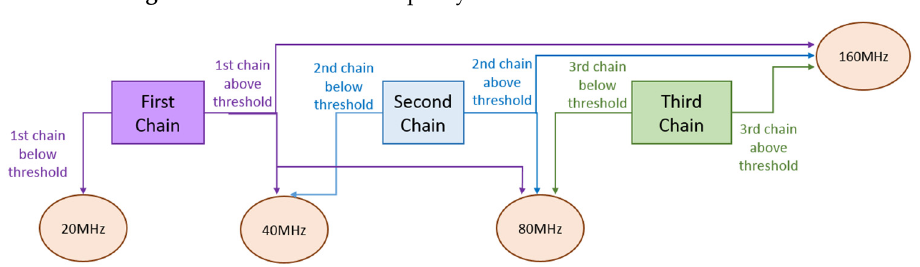
Figure 6. WuRx for two bits per symbol.